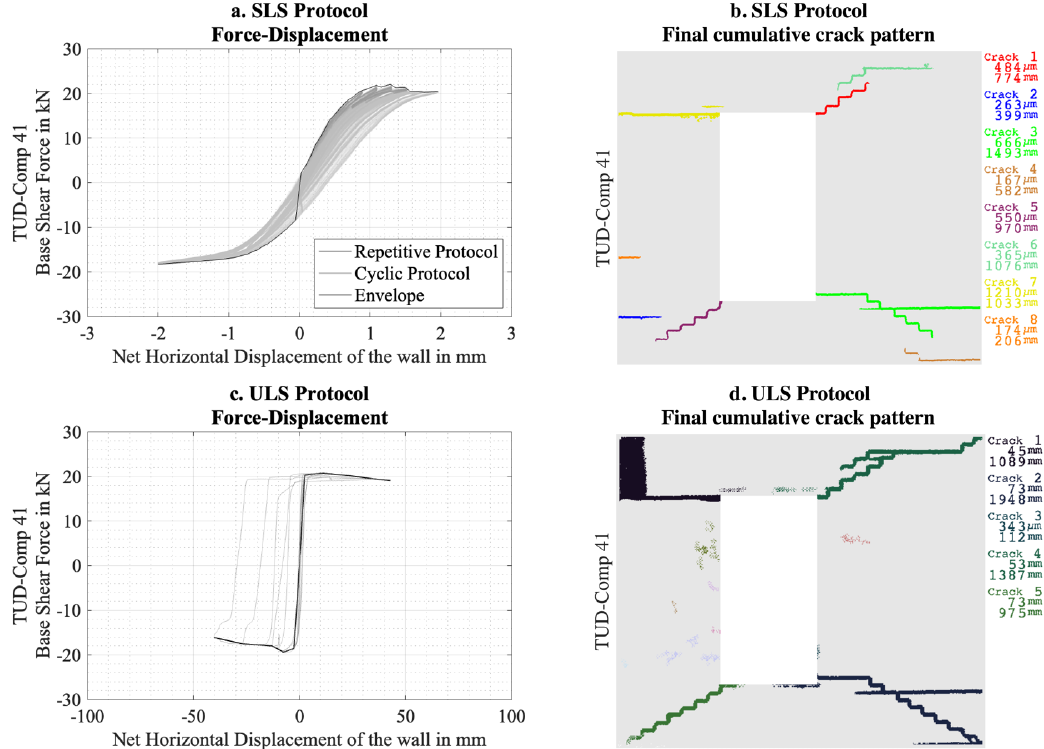
Figure 8. Results obtained on the unstrengthened wall (TUD-Comp41) in terms of base shear force versus net horizontal displacement curve and final cumulative crack pattern for the SLS and ULS protocol.